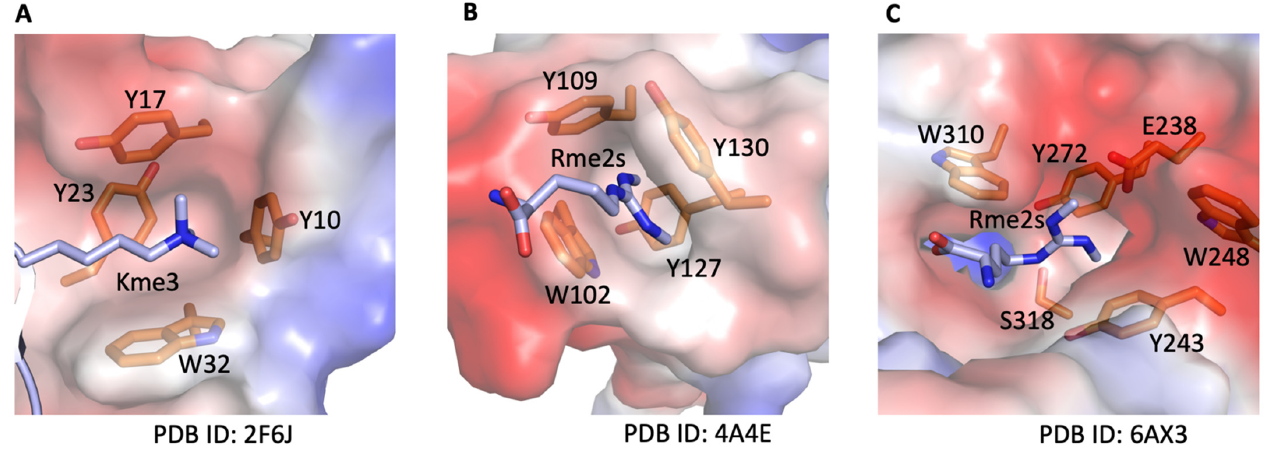
Figure 2. Methylation promotes the interaction between positively charged sidechains (cations) and aromatic cage ( π ). Kme3, trimethylation of Lysine; Rme2s, symmetric di-methylation of arginine. ( A ). Detailed interactions between PHD domain and tri-methylated lysine. ( B ). Detailed interactions between Tudor domain and symmetrically di-methylated arginine. ( C ). Detailed interactions between the substrate-binding domain of JMJD5 and symmetrically di-methylated arginine.